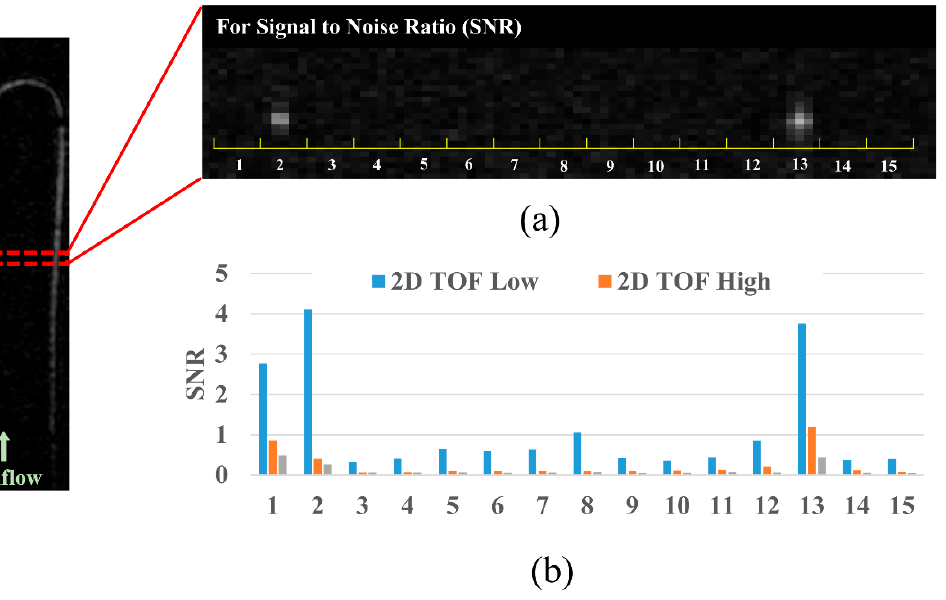
Table 4. SNRs of each TOF sequence at different tube diameters. Figure 3. Comparison of signal-to-noise ratios (SNR) according to the magnetic resonance angiography sequences. A coronal maximum intensity projection (MIP) image in the 1.0 mm tube diameter is provided for reference (left). ( a ) Axial MIP image of the selected regions of interest. ( b ) SNR graph of each sequence. Note that these data are representative of 1.0 mm tube diameter. Abbreviations: TOF, time-of-flight.